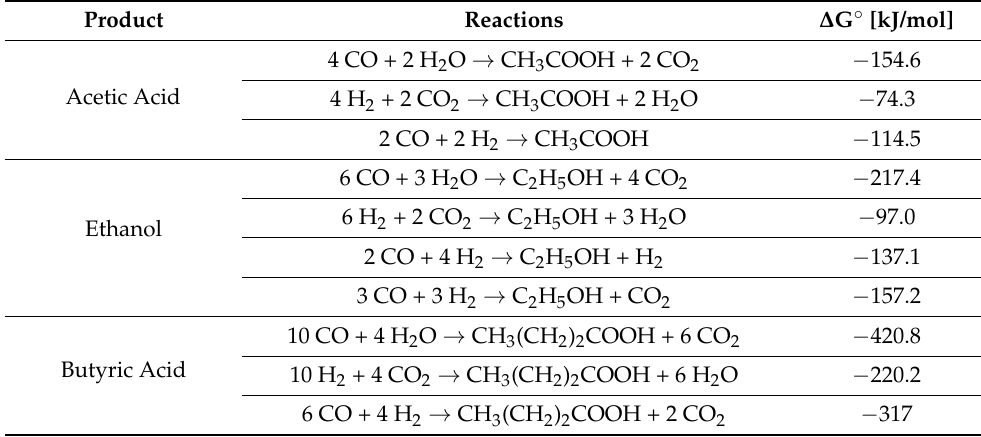
Table 2. The potential reaction of acetic acid, ethanol, butyric acid, butanol, hexanoic acid, and hexanol